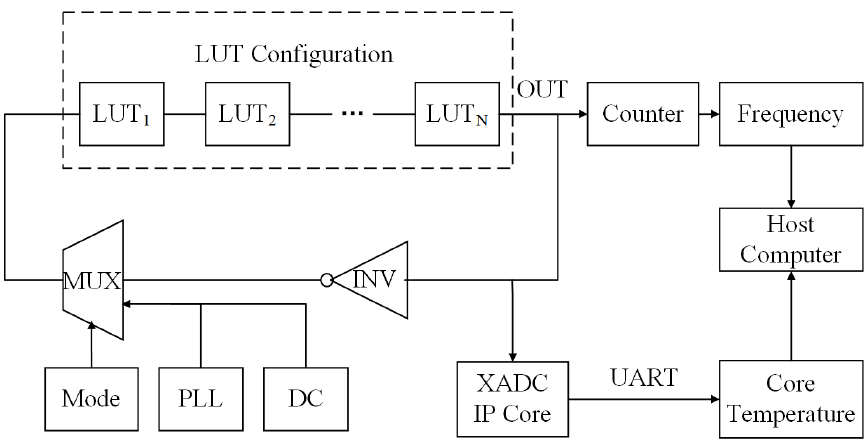
Figure 1. RO-based test structure.